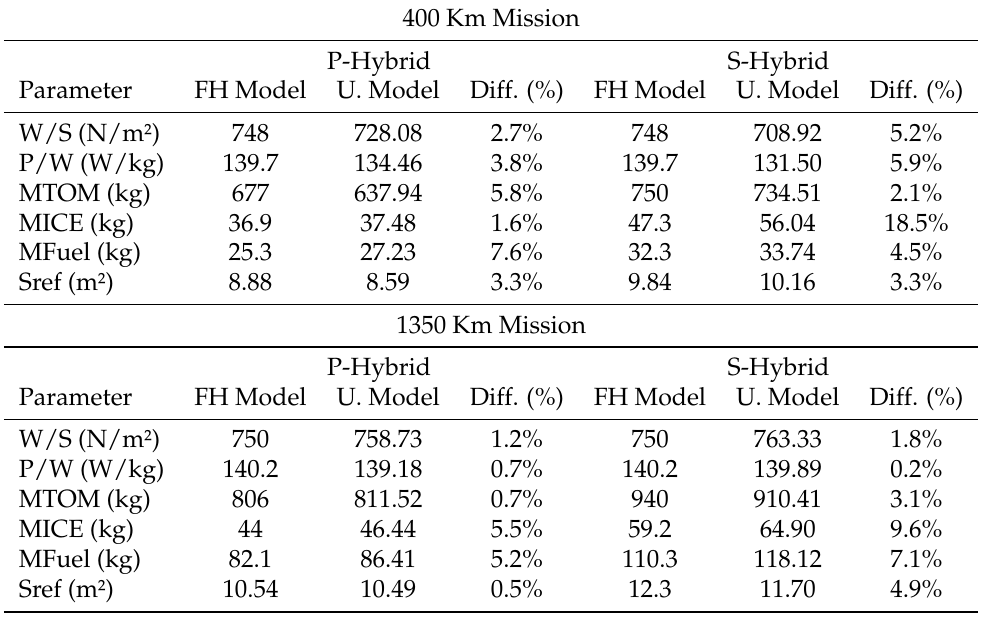
Table 5. Design variable